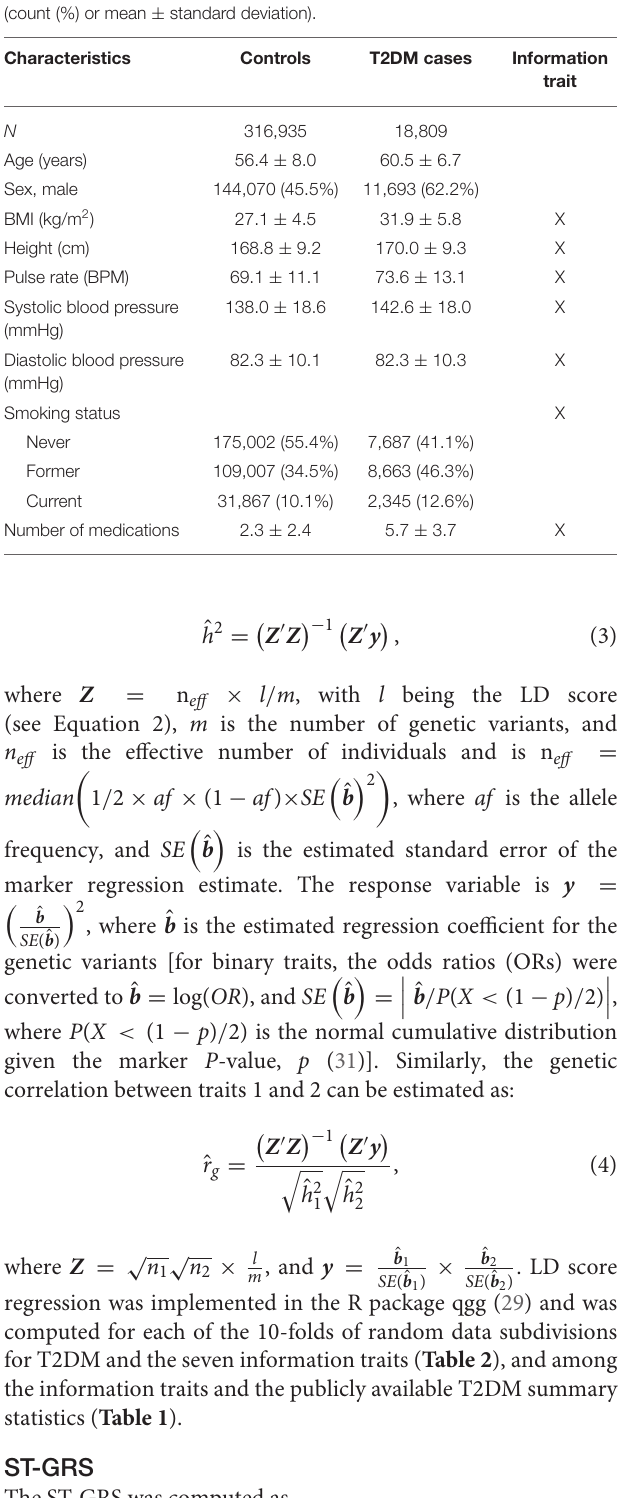
TABLE 2 | UKB cohort description ( n (count (%) or mean